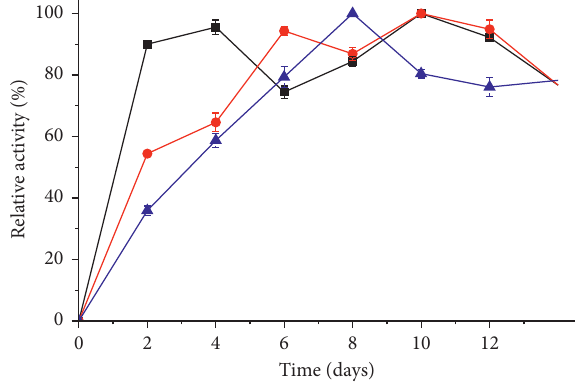
Figure 2: Production of endoglucanase ( ), exoglucanase ( ), and β -glucosidase ( ) by SSF of A. salmiana cellulose. The error bars represent the mean ± standard deviation (SD) of three